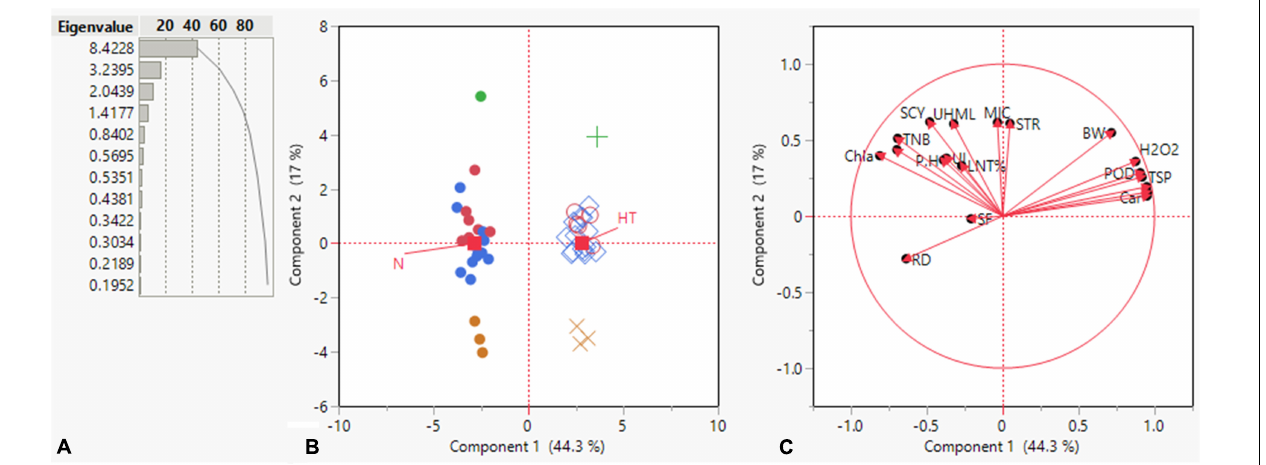
FIGURE 4 | Summary of (A) bar chart displaying eigenvalue and variation percentage contribution by all principal components (PCs), (B) a biplot between PC1 and PC2 displaying the distribution of 23 cotton genotypes under normal and high-temperature stress conditions (C) contribution of various traits in variation for genotypes under normal and high-temperature stress